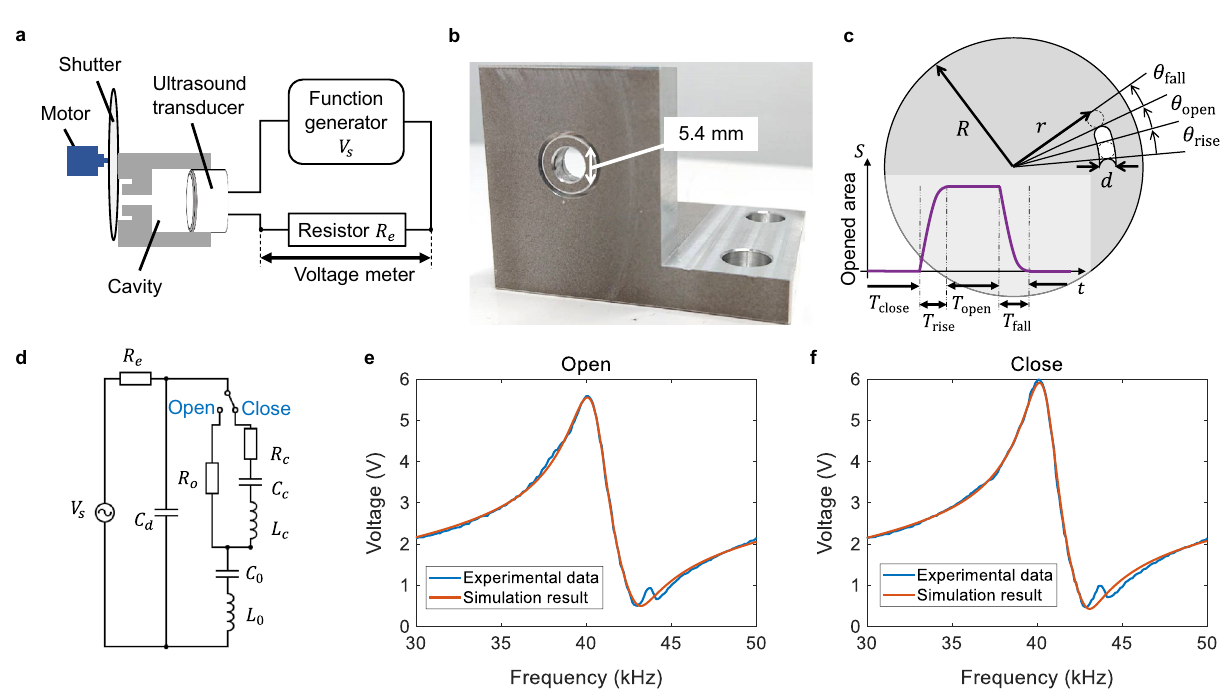
Figure 3. ( a ) Schematic of the cavity combined with the shutter and the transducer. The frequency response of the system can be measured by monitoring the voltage across the external resistor R e = 463 (cid:31) for different frequencies. ( b ) Photograph of the fabricated cavity made of aluminum. ( c ) Definition of the shutter geometry. ( d ) Equivalent circuit model of the switchable cavity. The AC voltage source is kept at 10 Vpp (5 V in amplitude) throughout this study. ( e,f ) Measured and calculated frequency response of the voltage across the external resistor R e when the shutter is opened ( e ) and closed ( f